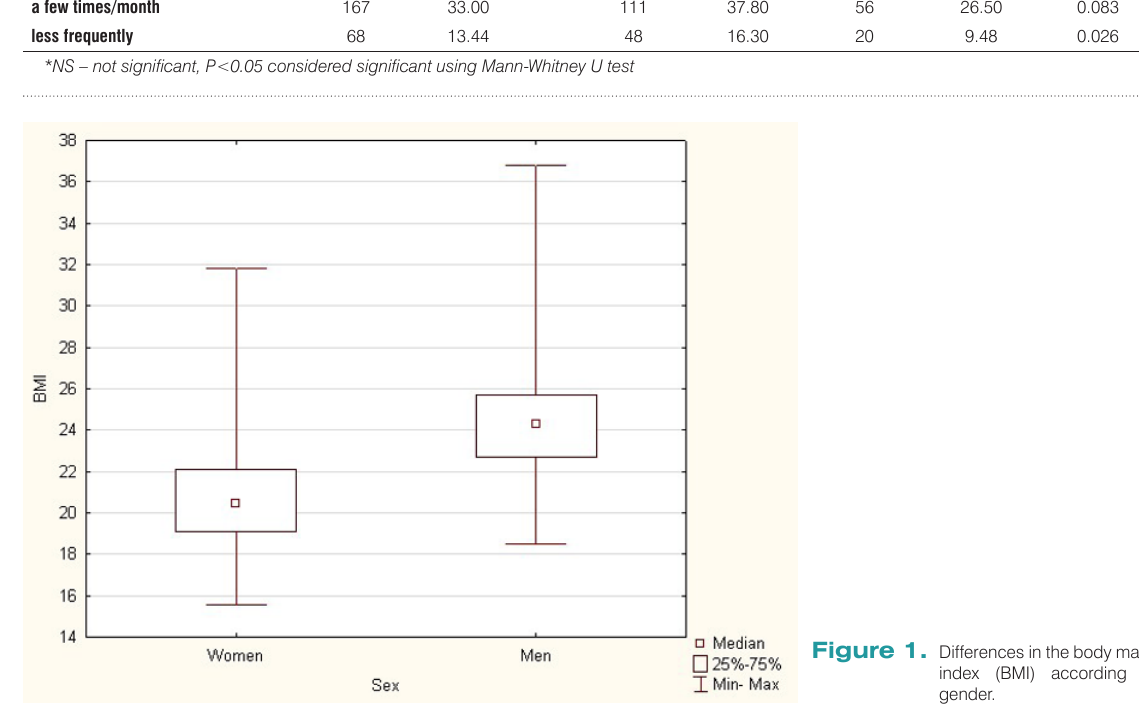
Figure 1. Differences in the body mass index (BMI) according to